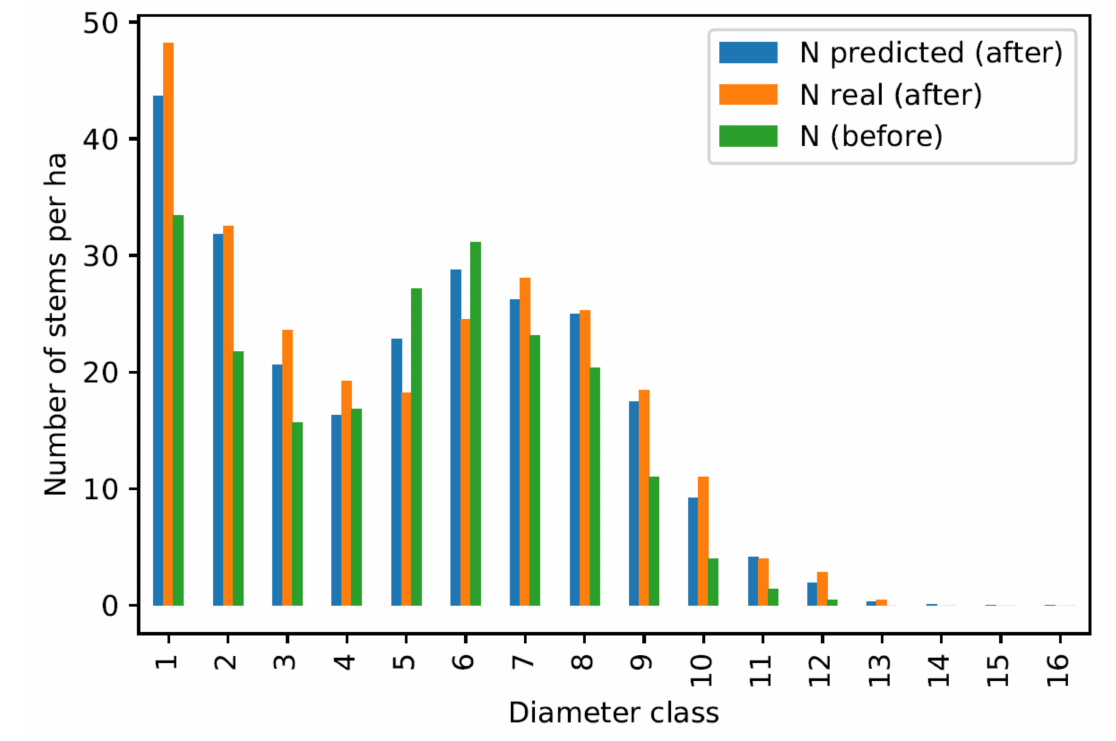
Figure 10. Overall prediction quality control for the division 809 inventoried in the year 1989.